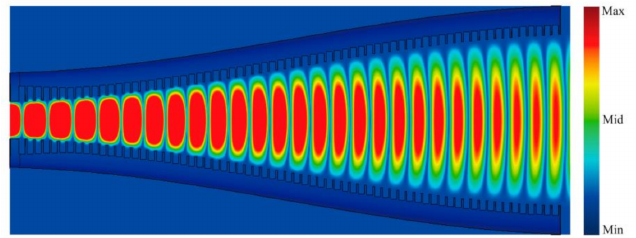
Figure 5. Cross-section electric field distribution at 330 GHz in the TE 11 -HE 11 mode